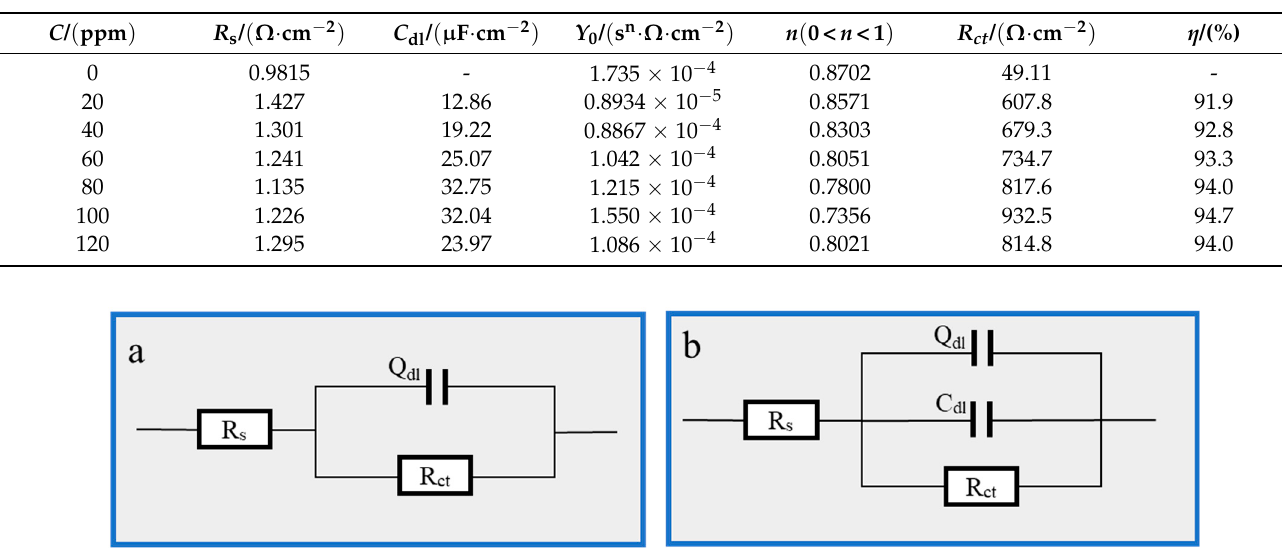
Figure 6. EIS fi tt ing equivalent circuit: ( a ) 1 M HCl; ( b ) Cu(II)@Thy-2 corrosion inhibitor added. Figure 6. EIS fitting equivalent circuit: ( a ) 1 M HCl; ( b ) Cu(II)@Thy-2 corrosion inhibitor